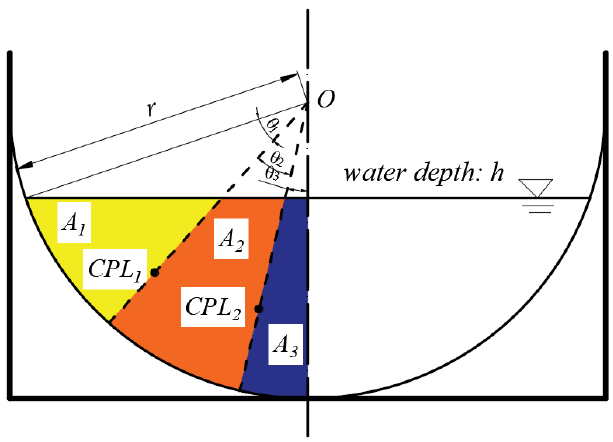
Figure 5. Discharge calculation in a semi-circular channel with the two-line method.